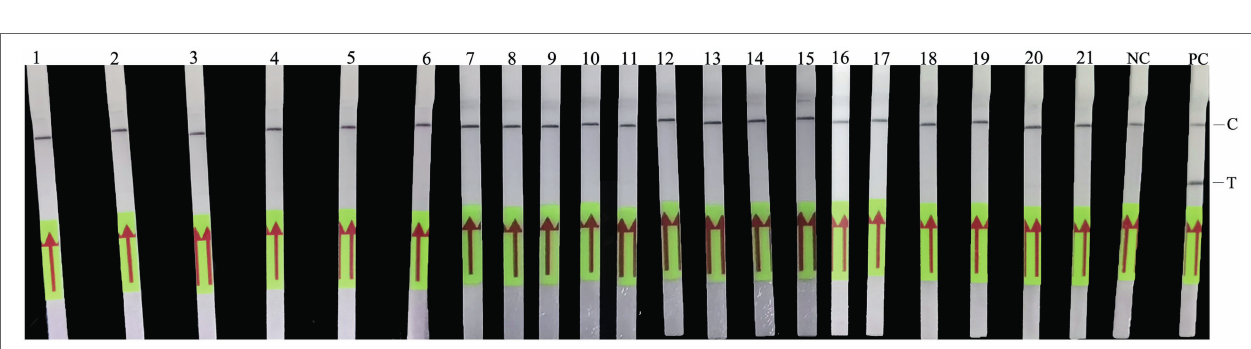
FIGURE 3 | Analytical specificity of the RAA-LF assay. Line 1: Anaplasma phagocytophilum ; Line 2: Rickettsia heilongjiangensis ; Line 3: R. rickettsia ; Line 4: R. sibirica ; Line 5: R. Canada ; Line 6: R. australis ; Line 7: R. typhi ; Line 8: R. prowazekii ; Line 9: Ehrlichia chaffeensis ; Line 10: Coxiella burnetii (Henzerling); Line 11: C. burnetii (QIYI); Line 12: Legionella pneumophila ; Line 13: Listeria monocytogenes ; Line 14: Salmonella typhimurium ; Line 15: Staphylococcus aureus ; Line 16: Vibrio cholera ; Line 17: Bartonella henselae ; Line 18: Bartonella quintana ; Line 19: Streptococcus suis ; Line 20: Shigella sonnei ; Line 21: Chlamydia trachomatis ; NC: negative control; PC: C. psittaci . A positive result was determined when both the low line of test (T) and the upper line of control (C) developed. Only C line occurrence indicated a negative